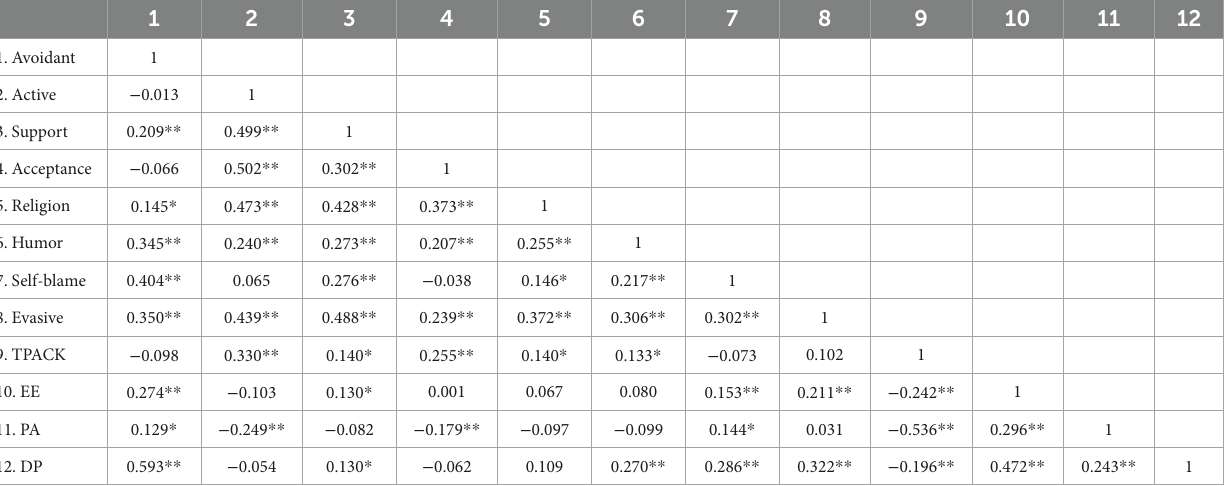
TABLE 3 Inter-correlations between the variables of the study.